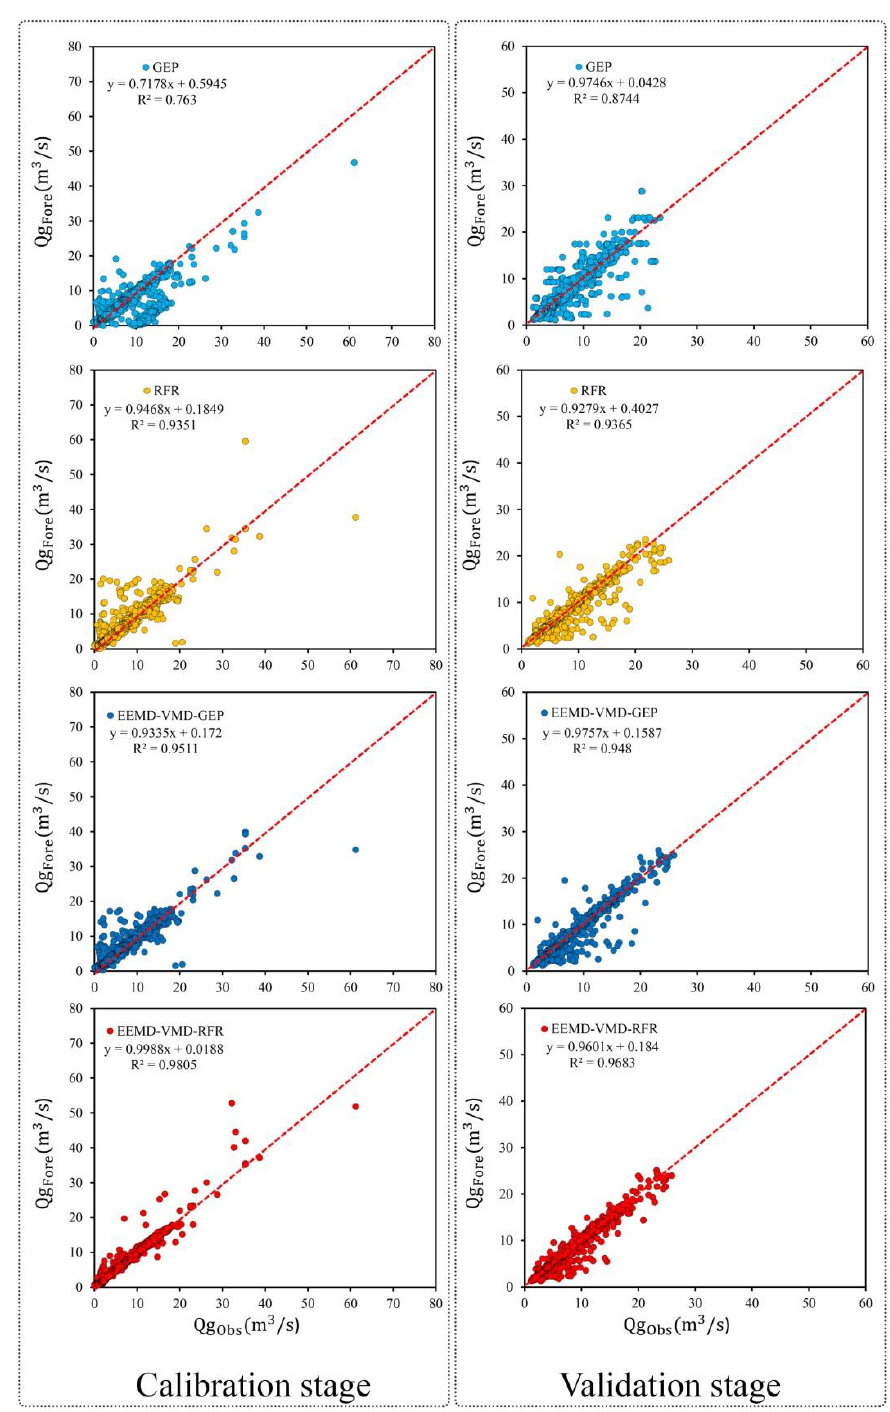
Figure 11. Scatterplot of forecasted (Q Obs ) and observed (Q Fore ) river flow using the standalone GEP, RFR, and ensemble EEMD-VMD-GEP, EEMD-VMD-RFR models for the calibration and validation periods at the Gachsar station.